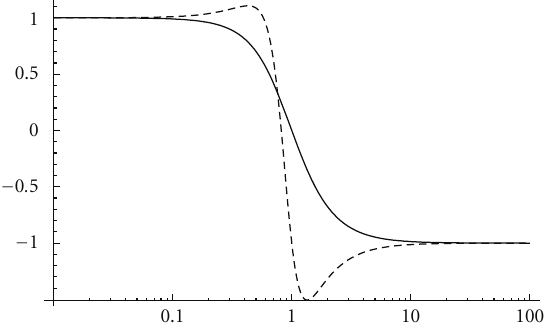
Figure 1: log linear plot of ω ϕ as a function of the dimensionless variable κ ˙ ϕ for γ = 1 and γ = − 1